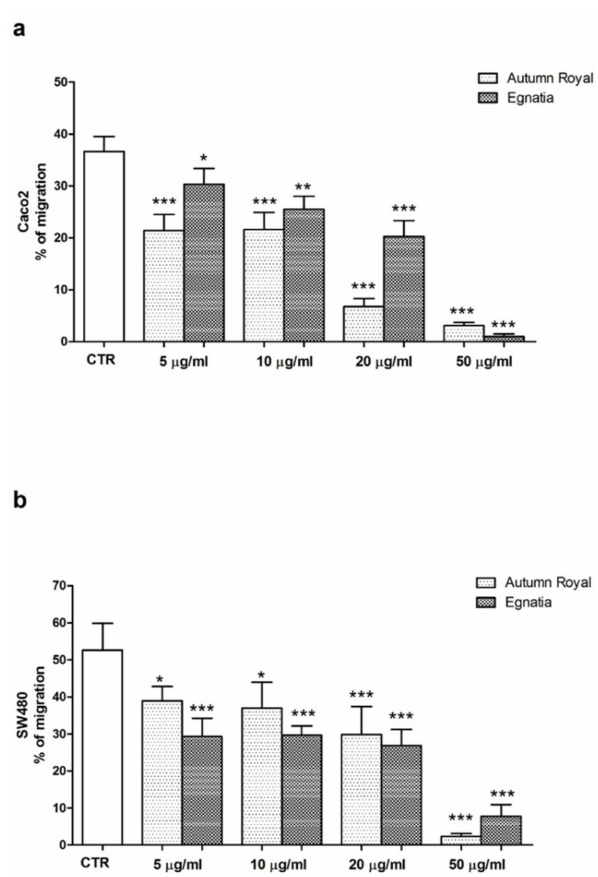
Figure 5. ( a ) Inhibitory e ff ect on migration of Caco2 cells treated with increasing concentrations of Autumn Royal and Egnatia GSEs (5, 10, 20, and 50 µ g / mL) for 48 h; ( b ) Inhibitory e ff ect on migration of SW480 cells treated with increasing concentrations of Autumn Royal and Egnatia GSEs (5, 10, 20, and 50 µ g / mL) for 48 h. Data represent the percentage of migration expressed as mean ± Standard Deviation (SD) of treated cells respect to control group (CTR) from three independent experiments performed in triplicate. p -value was determined by ANOVA with Dunnett’s post-test. * p < 0.05, ** p < 0.03 and *** p <